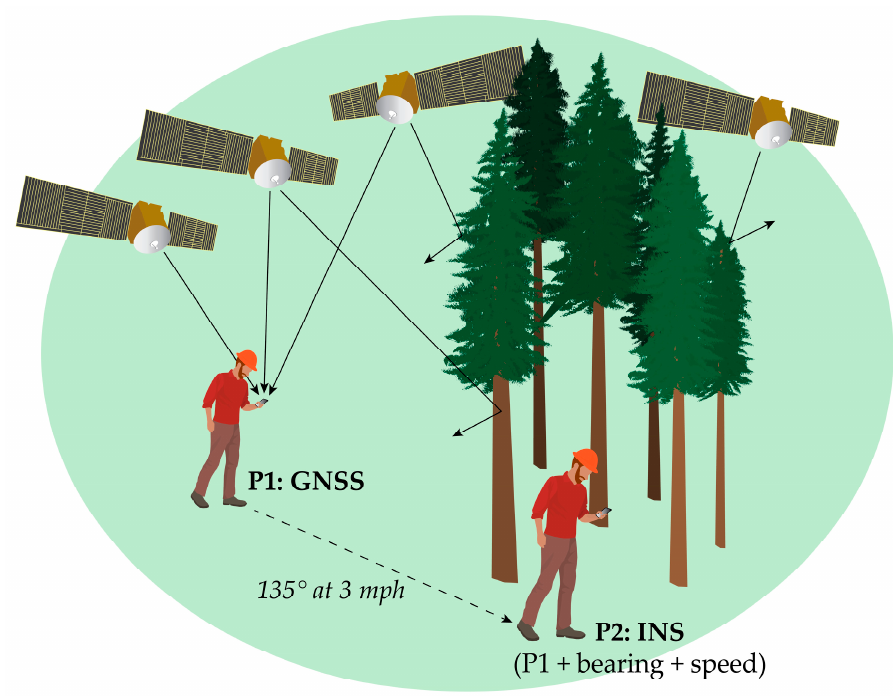
Figure 6. Inertial Navigation Systems (INS) in the forest. The forester’s coordinates are determined by GNSS at the first position (P1). The INS in his device tracks the direction and speed of his movement and can calculate his second position (P2) in the dense canopy based on where the forester has traveled from his last known GNSS coordinate.